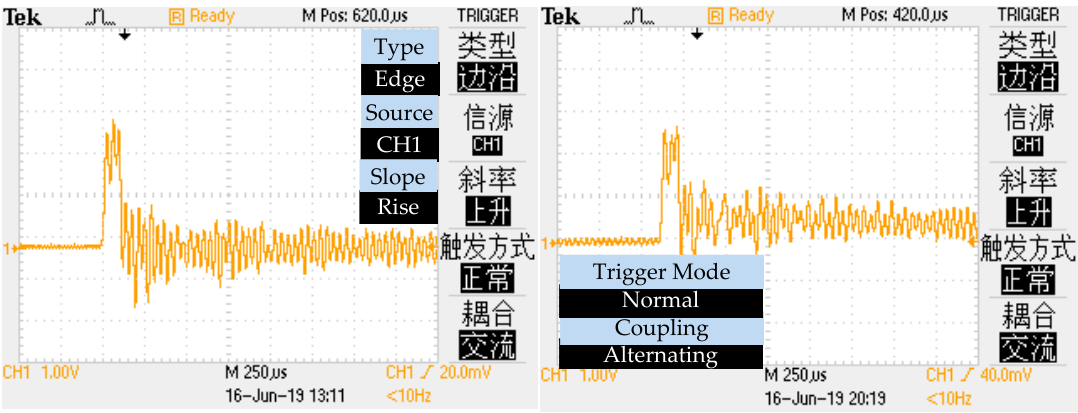
Figure 5. The experimental output signal under normal temperature ( a ) and 260 °C ( b ).